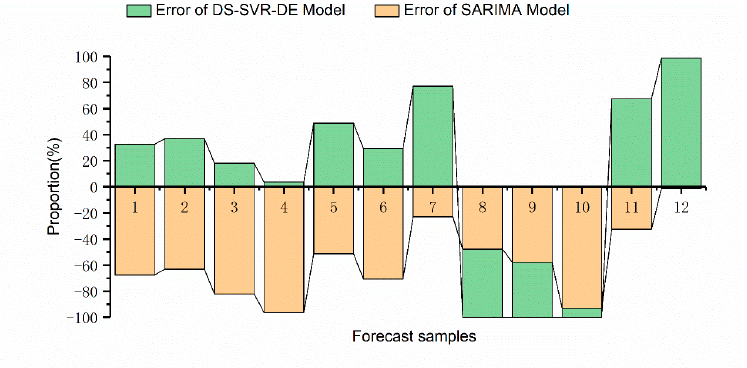
Figure 7. A comparison of long-term prediction errors between the proposed DS-SVR model and the SARIMA model in the medium-sized type.